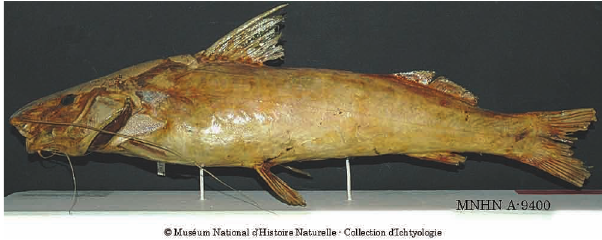
Fig. 2. Arius albicans Valenciennes, 1840 (= Pimelodus albicans ), holotype, MNHN 9400, 485 mm SL, Buénos- Ayres [= Buenos Aires, Argentina]. Photo by Hautecoeur